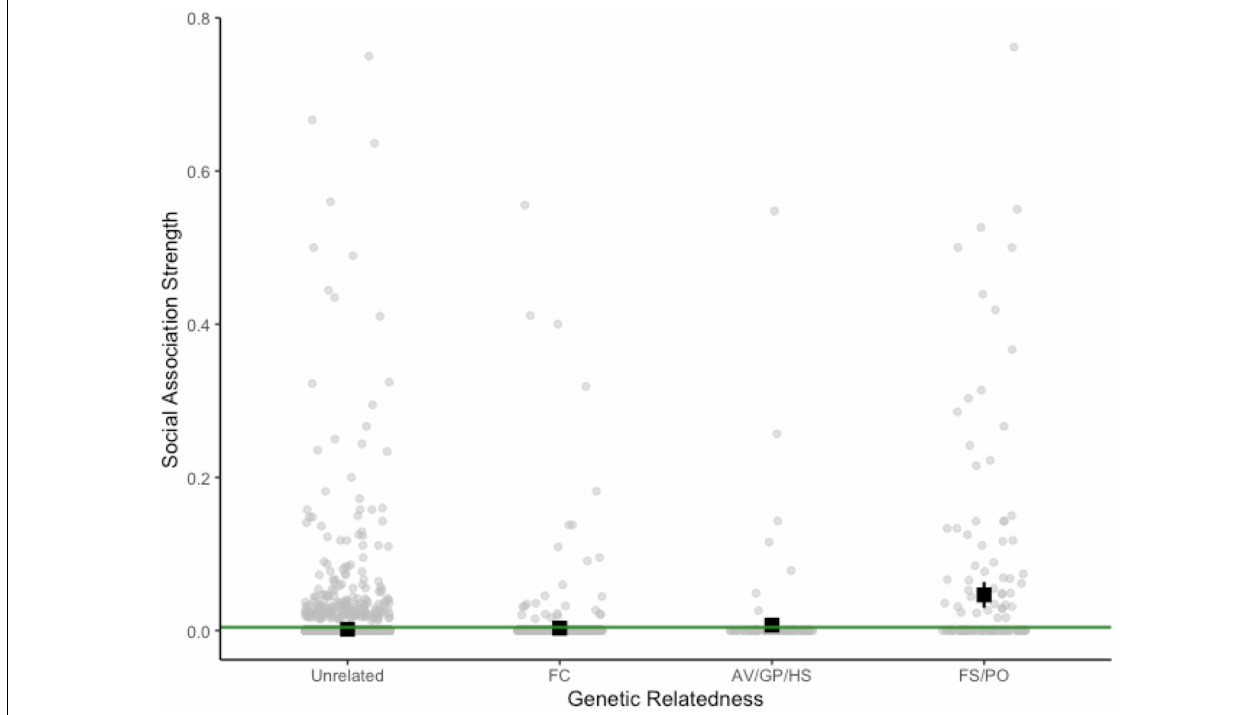
FIGURE 3 | Strength of social associations (HWI) that we observed between Tree Skink dyads in our Albury, NSW population over two active seasons (2014–2016) as plotted against the genetic relatedness between those individuals. The green line represents the threshold (HWI > 0.004) over which individual social relationships are considered “preferred.” The genetic relatedness categories were delineated based on our approximate error rates depicted in Supplementary Figure 3 : unrelated ( R = 0–0.625, n = 9,425 dyads), first cousin (FC, R = 0.625–0.188, n = 949 dyads), avuncular/grandparent-grandchild/half sibling (AV/GP/HS; R = 0.188–0.313, n = 172 dyads) and full sibling/parent-offspring (FS/PO, R = 0.313–0.664, n = 184 dyads). For each category of genetic relatedness, the black square and lines show the mean HWI ± 95% confidence intervals. In this plot each individual is replicated multiple times, such that counts represent all possible pairwise combinations of individuals ( n = 10,730